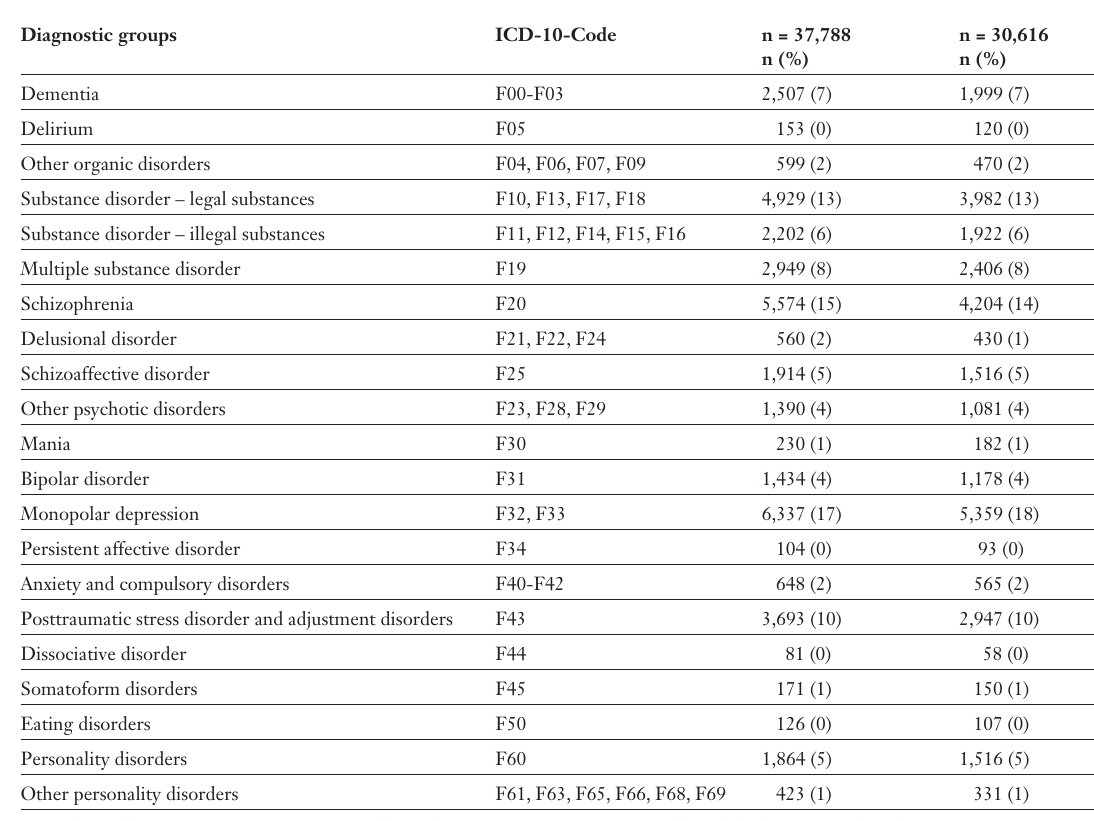
Table 1 Comparison of patients meeting inclusion criteria and patients included in statistical analyses: ICD-based